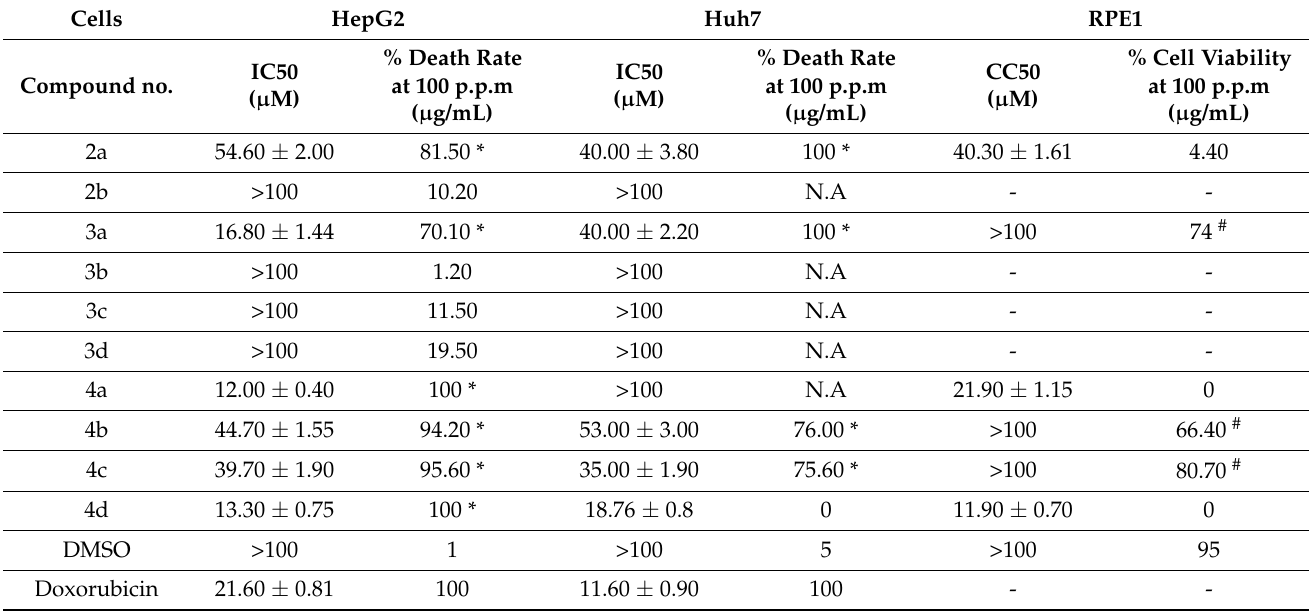
Table 1. The in vitro cytotoxic activity of isatin sulfonamide derivatives on HepG2 and Huh7 cell lines (10 compounds) and in vitro safety assay towards normal human retina pigmented epithelial (RPE1) cell line (6 compounds) using MTT assay.